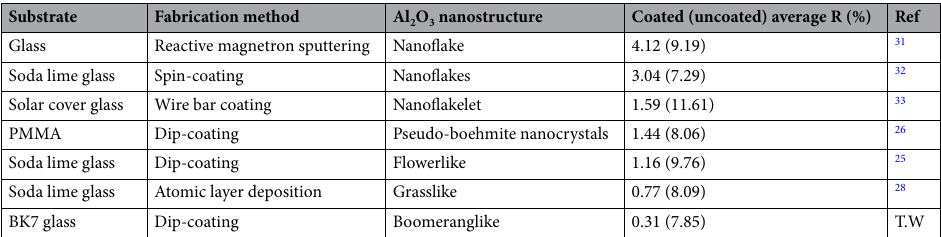
Table 1. Comparison of various fabrication techniques used for Al 2 O 3 based single-layer antireflection coatings in visible region (400–700